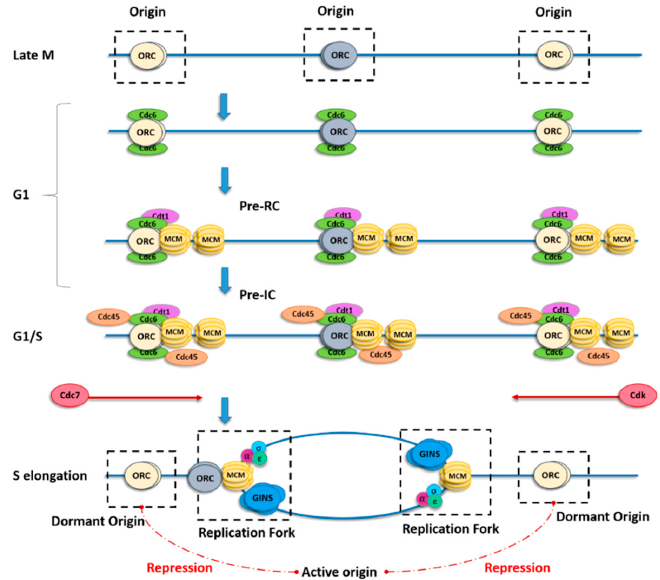
Figure 1. Scheme describing origin licensing and firing. In late mitosis (M), the origin recognition complex (ORC) binds to origins, thus determining where replication forks might initiate, and for the subsequent recruitment of cell division cycle 6 (Cdc6) and chromatin licensing and DNA replication factor 1 (Cdt1) in the gap 1 (G1) phase. Binding of both Cdc6 and Cdt1 is necessary, in turn, for recruitment of the minichromosome maintenance DNA helicase complex (MCM) to form the pre-recognition complex (Pre-RC). Each ORC has two Cdt1-binding sites, which may explain the cooperative loading of two MCM complexes per origin. The MCM pair remains catalytically inactive until the G1–synthesis (S) phase transition, when it is phosphorylated by both cyclin-dependent kinase (CDK) and Cdc7. Once the principal origin is fired, adjacent origins from the same replicon (flexible or dormant) are repressed (red dotted lines) by a yet unclear